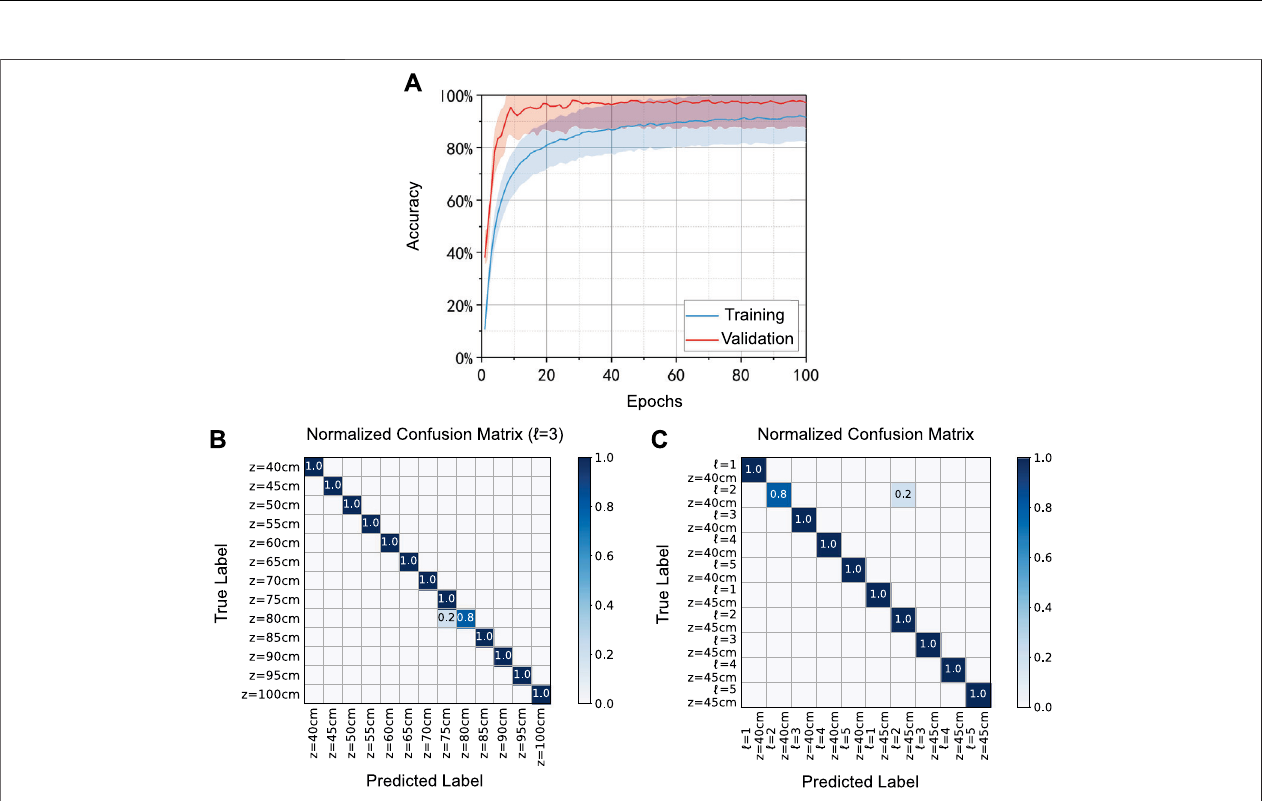
FIGURE4| Theaccuracyandconfusionmatrixofourtraineddeeplearningalgorithm. (A) Theaccuracyofthetrainingsetandthevalidationsetversustheepochs. The accuracy of up to 97% is achieved in identifying vortex beams with different ℓ values and different z values after 90 epochs. All shaded areas correspond to the standard deviation of accuracy. All classi fi cation results have been tested and veri fi ed, and some test results are shown here. (B) The normalized confusion matrix between the predicted propagation distance and the true propagation distance for ℓ = 3. (C) Normalized confusion matrix between predicted ℓ values, predicted propagation distance and true ℓ values, true propagation